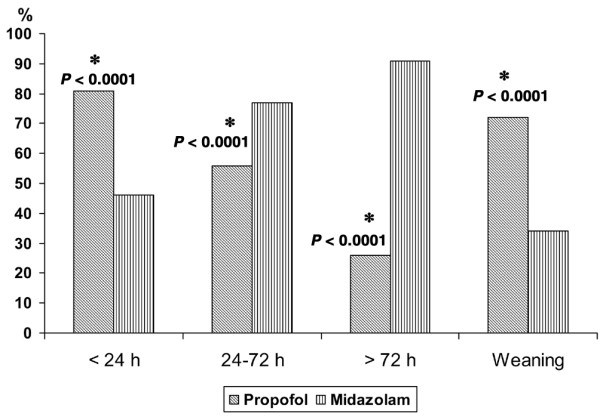
The most commonly used sedative agents for the different sedation periods. *Differences between midazolam and propofol in a phase (χ2 test, P < 0.05). The values were tested with the χ2 test (P < 0.05) and multiple differences with the Bonferroni–Holm multiple test procedure. (Propofol: less than 24 hours versus 24–72 hours versus more than 72 hours versus weaning, all P < 0.0001. Midazolam: less than 24 hours versus 24–72 hours versus more than 72 hours versus weaning, all P < 0.0001.)